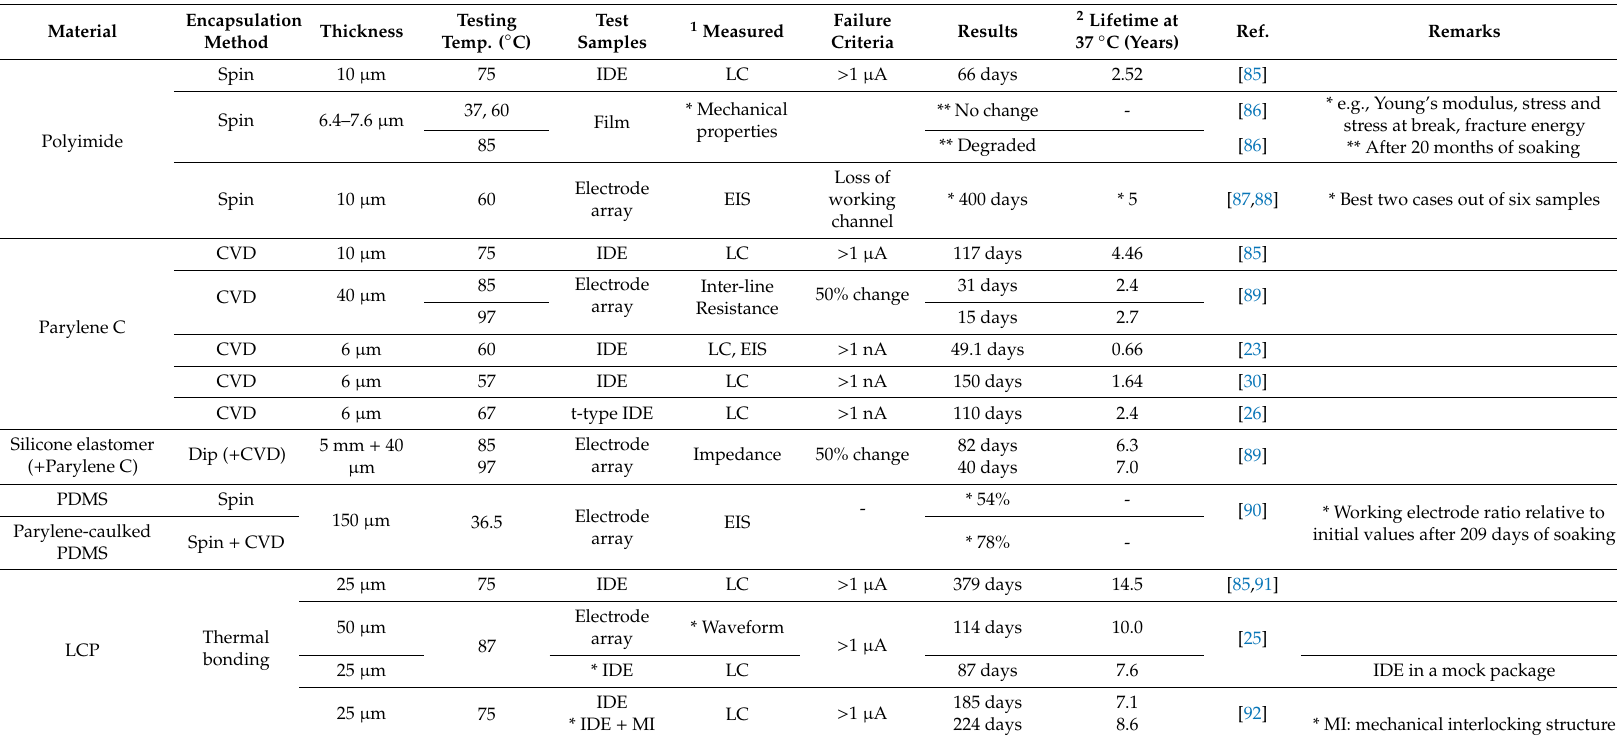
Table 3. Summary of selected results from long-term reliability tests of various organic encapsulation